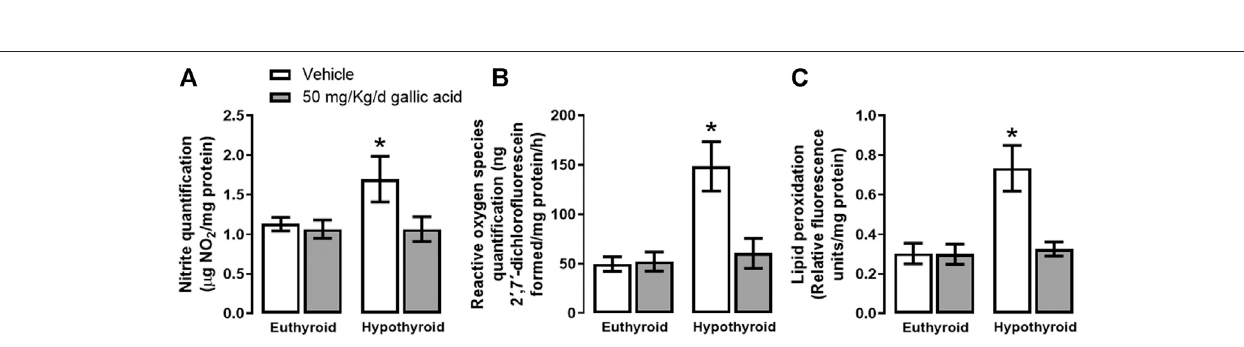
Frontiers in Pharmacology |